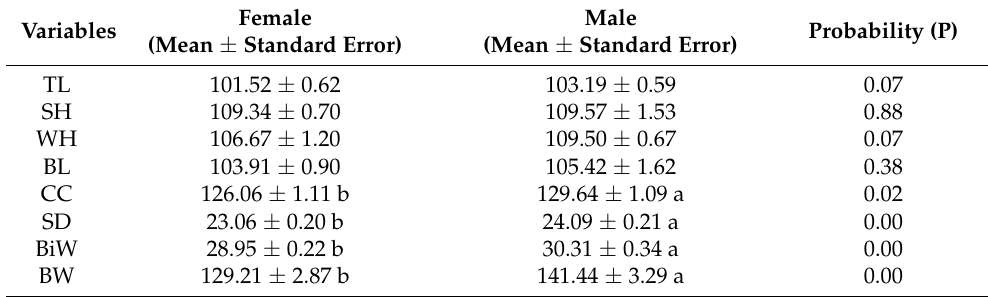
Table 1. Descriptive statistics.